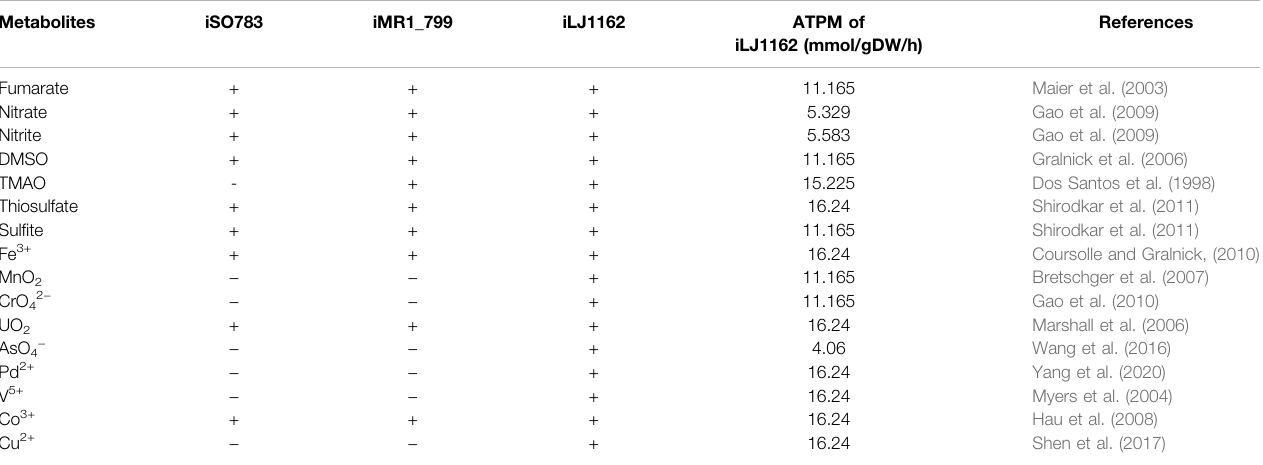
TABLE 1 | Simulation results of 16 terminal electron acceptors by three